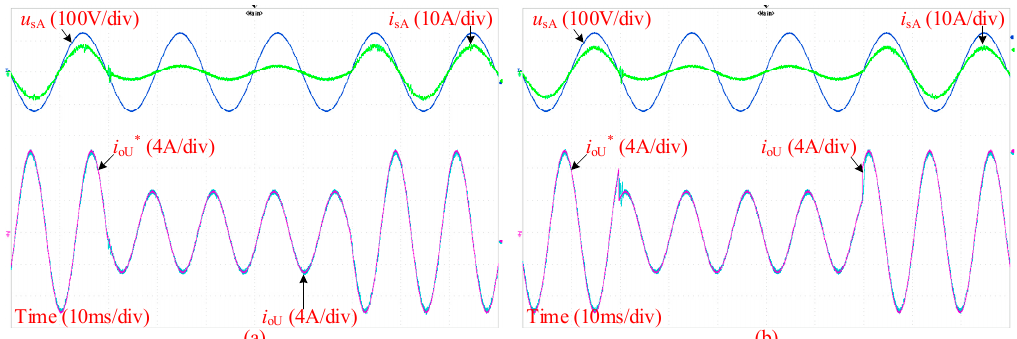
Figure 11. Experimental results of Case 6: ( a ) with the conventional MPC and ( b ) with the improved MPC. The reference amplitude of the output current steps between 10A and 5A.